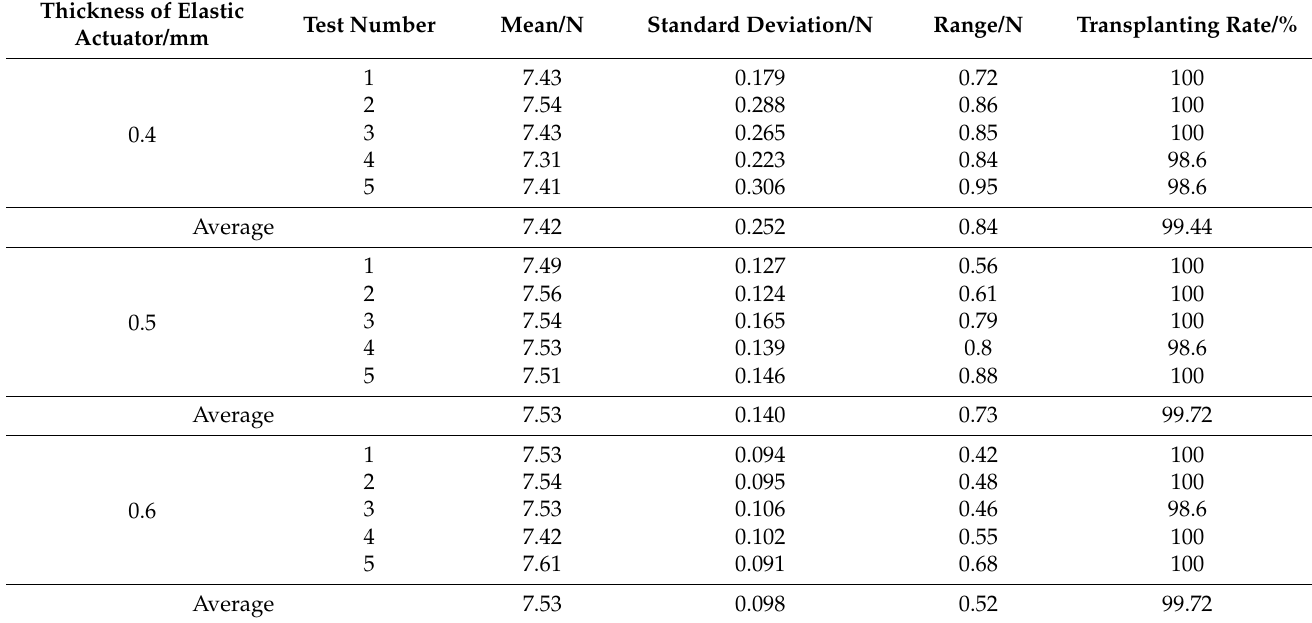
Table 2. Statistical results of cavity tray seedling clamping force